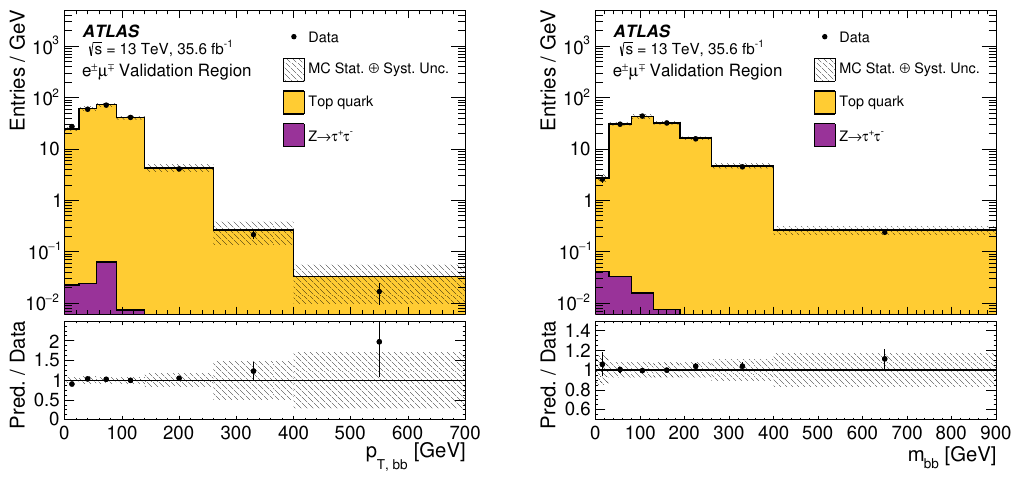
Figure 1 . Transverse momentum (left) and invariant mass (right) of the di- b -jet system built with the two highest- p T b -jets for events with at least two b -jets in the t (cid:22) t validation region. Systematic uncertainties of the predicted distributions are combined with the statistical ones in the hatched band, and the statistical uncertainty of the data is shown as error bars. The systematic uncertainties for the predictions account only for the yield and the shape of t (cid:22) t